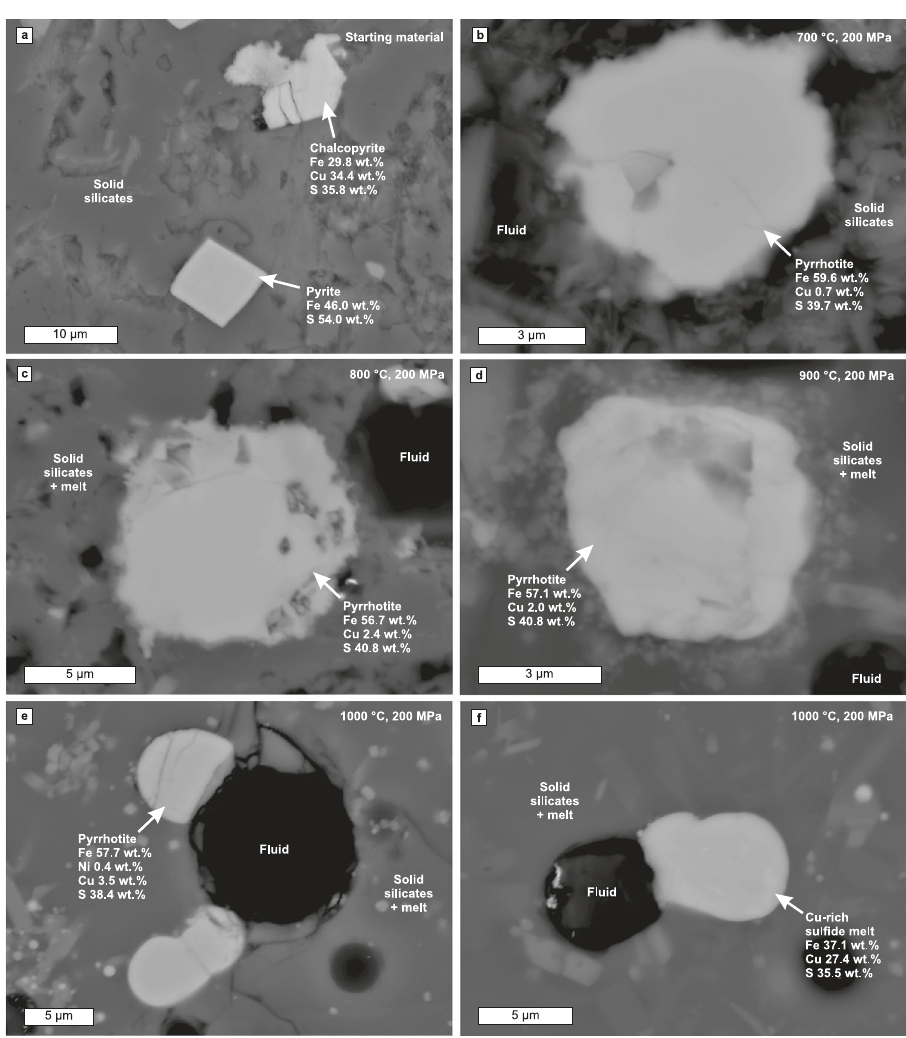
Fig. 2 Back-scattered electron images of sulphides from the Virginia Formation black shale and the heating and partial melting experiments. The images are from a starting material and experiments at b 700 °C, c 800 °C, d 900°C, and e – f 1000°C. The compositions (Supplementary Data 3 – 7) have been measured with energy-dispersive detector of FE-SEM. Note that the “ Fluid ” indicates empty vesicles, which were fi lled with fl uid during the experiment and that the “ Melt ” indicates glass that represents quenched